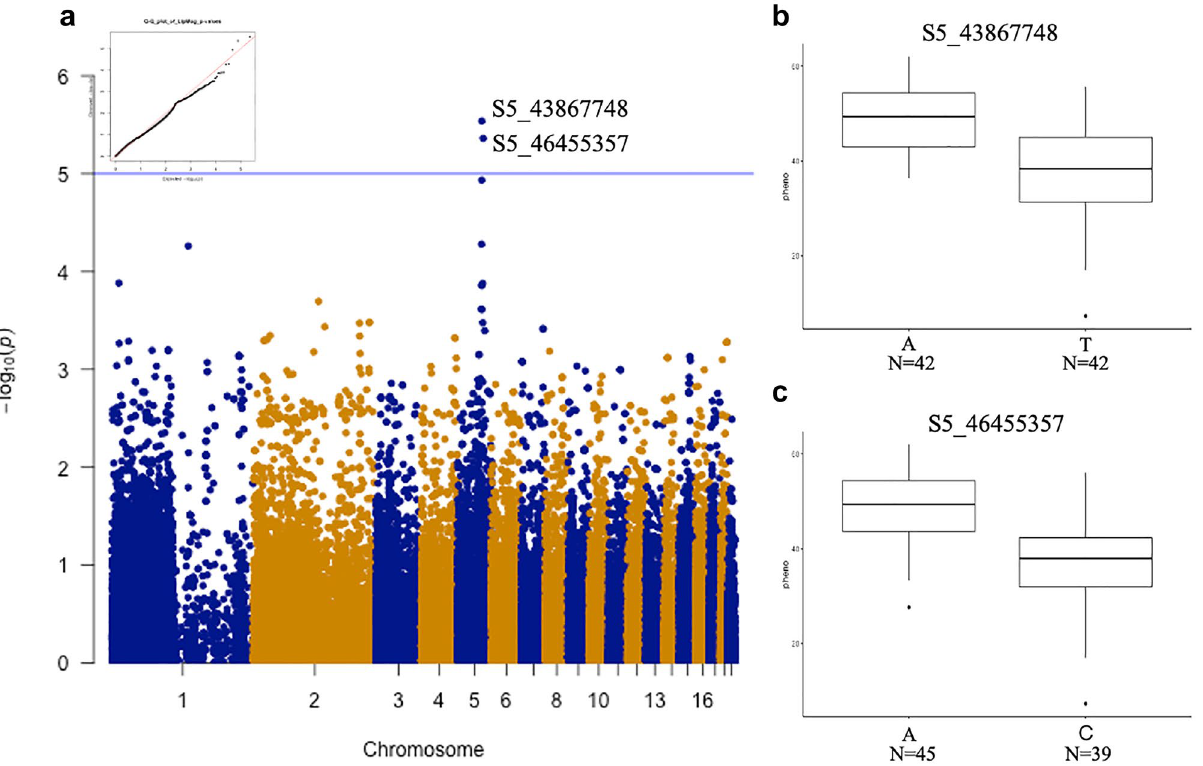
Figure 5. GWAS of lip magenta color. ( a ) Manhattan plot of lip magenta color, ( b ) difference in lip Magenta color level by SNP type at position S5-43867748, ( c ) SNP type at position S5-46455357. N indicates the individual number of this